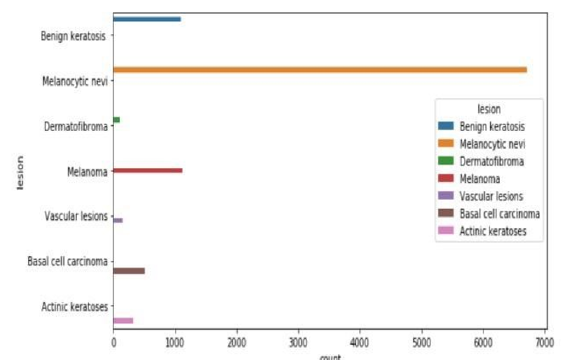
Figure 4.1 : Satistics of dermoscipic images used in experimentation